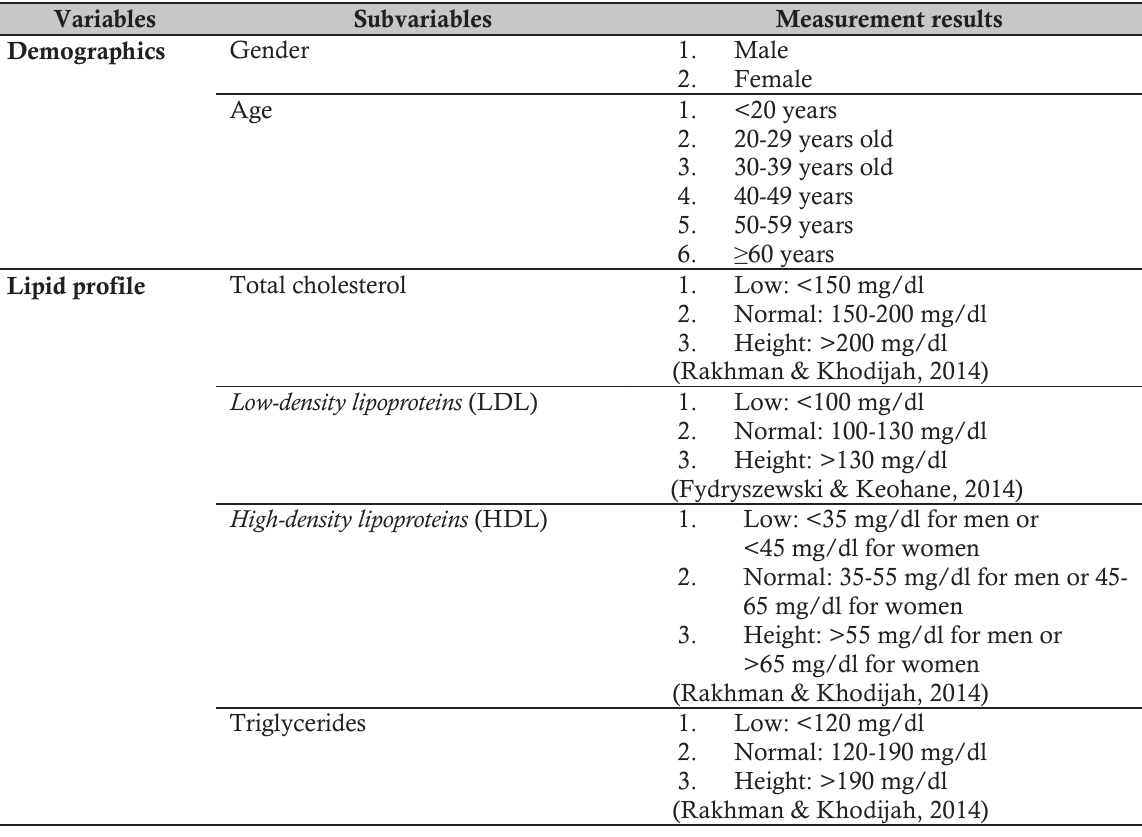
Figure 1. Research sampling process scheme Table 2. References of Research Variables